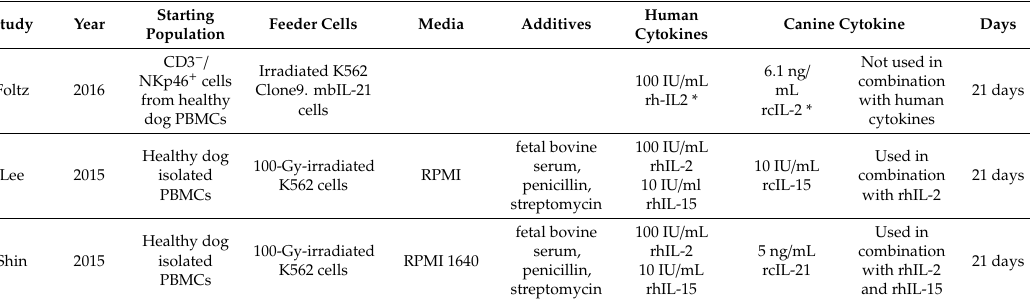
Table 2. Recombinant Canine Cytokines for ex vivo NK